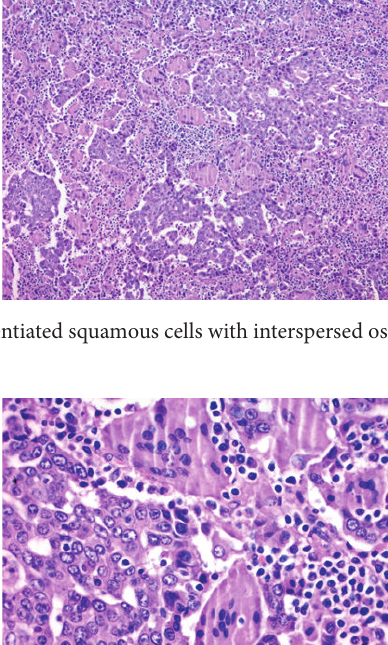
lymphovascular invasion was identified.